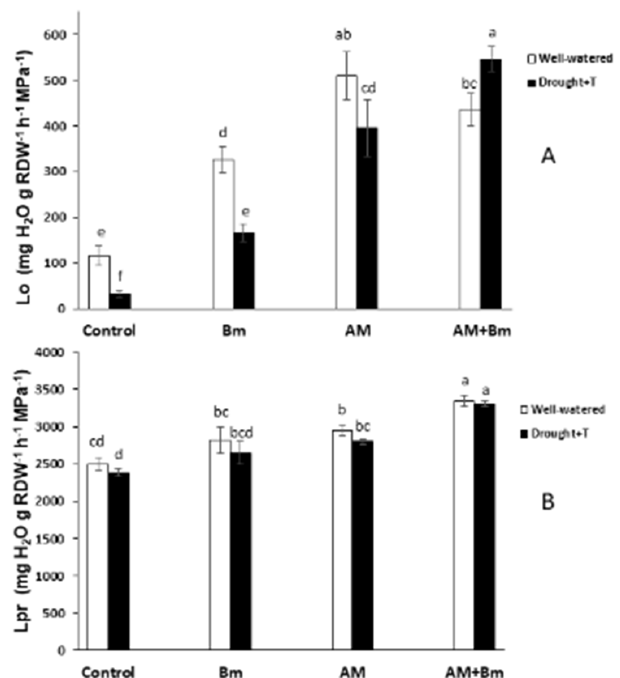
Figure 5. ( A ) Osmotic root hydraulic conductivity ( Lo ) and ( B ) hydrostatic root hydraulic conductivity ( Lpr ) in maize plants inoculated or not (control) with a PGPR strain of Bacillus megaterium (Bm), with the arbuscular mycorrhizal fungus Rhizophagus irregularis (AM) or with both microorganisms (AM + Bm). Plants were cultivated under standard ambient temperature and well-watering conditions (well-watered) or subjected to a combined drought and high temperature stress (drought + T) for 15 days before harvest. Data represent the means (n = 8) ( Lo ) or (n = 7) ( Lpr ) ± S.E. Different letters indicate significant differences between treatments ( p < 0.05) based on Duncan’s test.